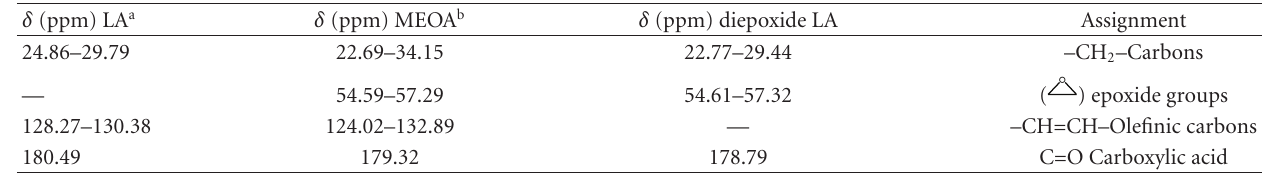
Table 8: The main signals present in 13 C NMR functional groups of LA, MEOA, and diepoxide LA.